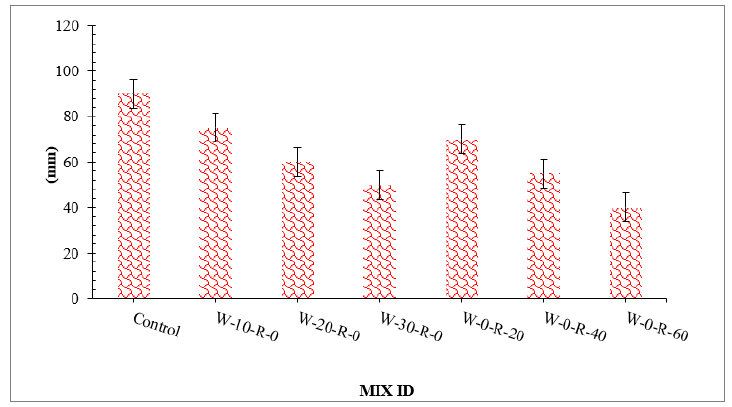
Figure 4. Slump test result.